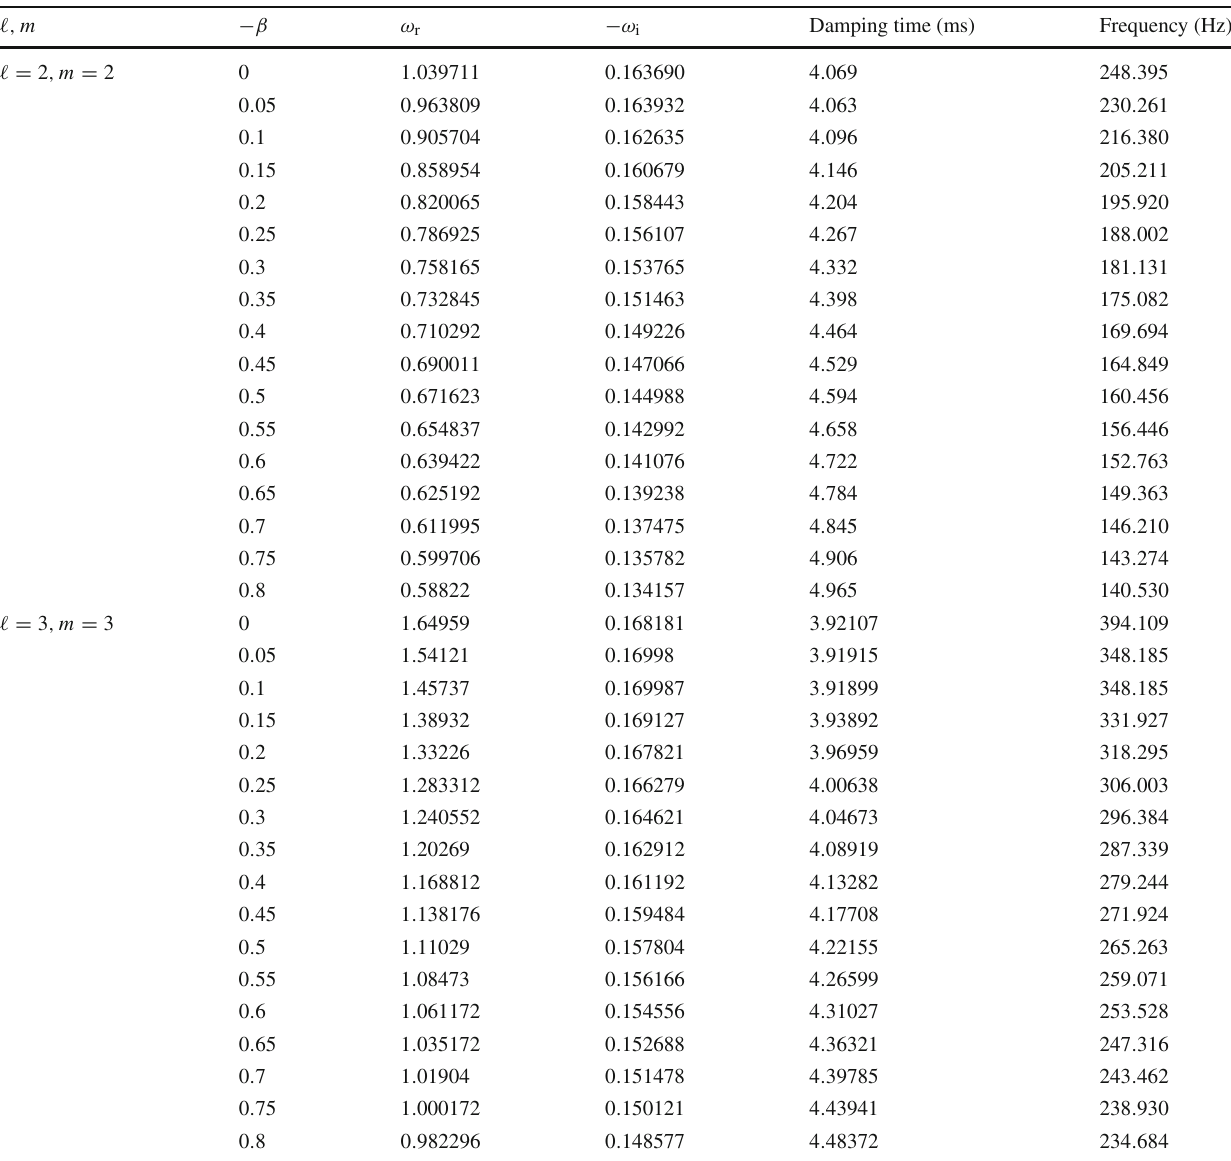
Table 1 Numerical values of the real and imaginary parts of the excited QNM ( n = 0 ,(cid:3) = 3 = m ) frequencies, along with the oscilla- tion frequency and damping time, corresponding to the gravitational perturbation ( s = − 2 ) , for various values of tidal charge parameter β have been presented, for a BH of mass M = 62 M (cid:8) and dimen-